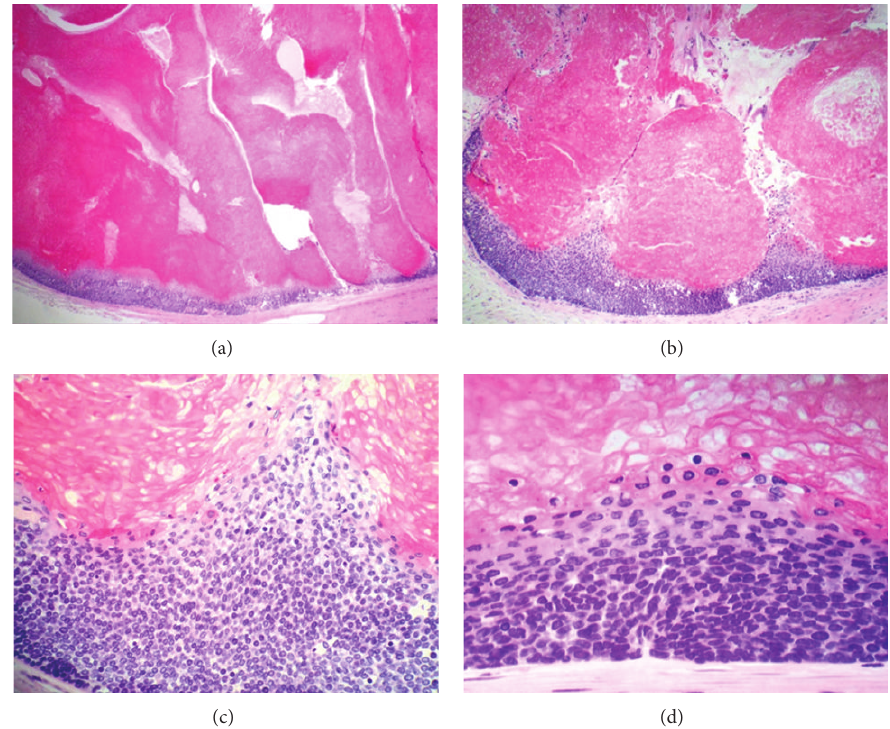
Figure 4: Histologic features of pilomatrixoma. ((a) and (b)) The tumor is composed of a biphasic population of basaloid and ghost cells. ((c) and (d)) Maturation of basaloid cells (bottom) into ghost cells (top). The cells become larger, acquire eosinophilic cytoplasm, and eventually lose their nuclei (H&E, × 40 (a), × 100 (b), × 400 (c), and × 600 (d)).